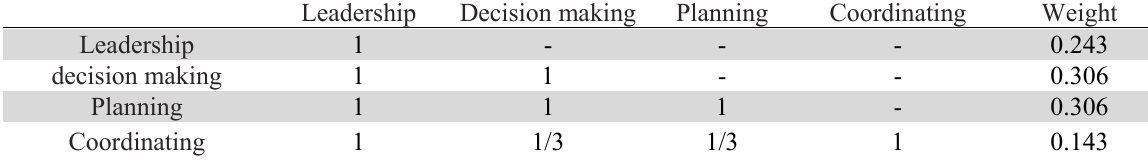
Comparisons in third level, knowledge management and technical skills